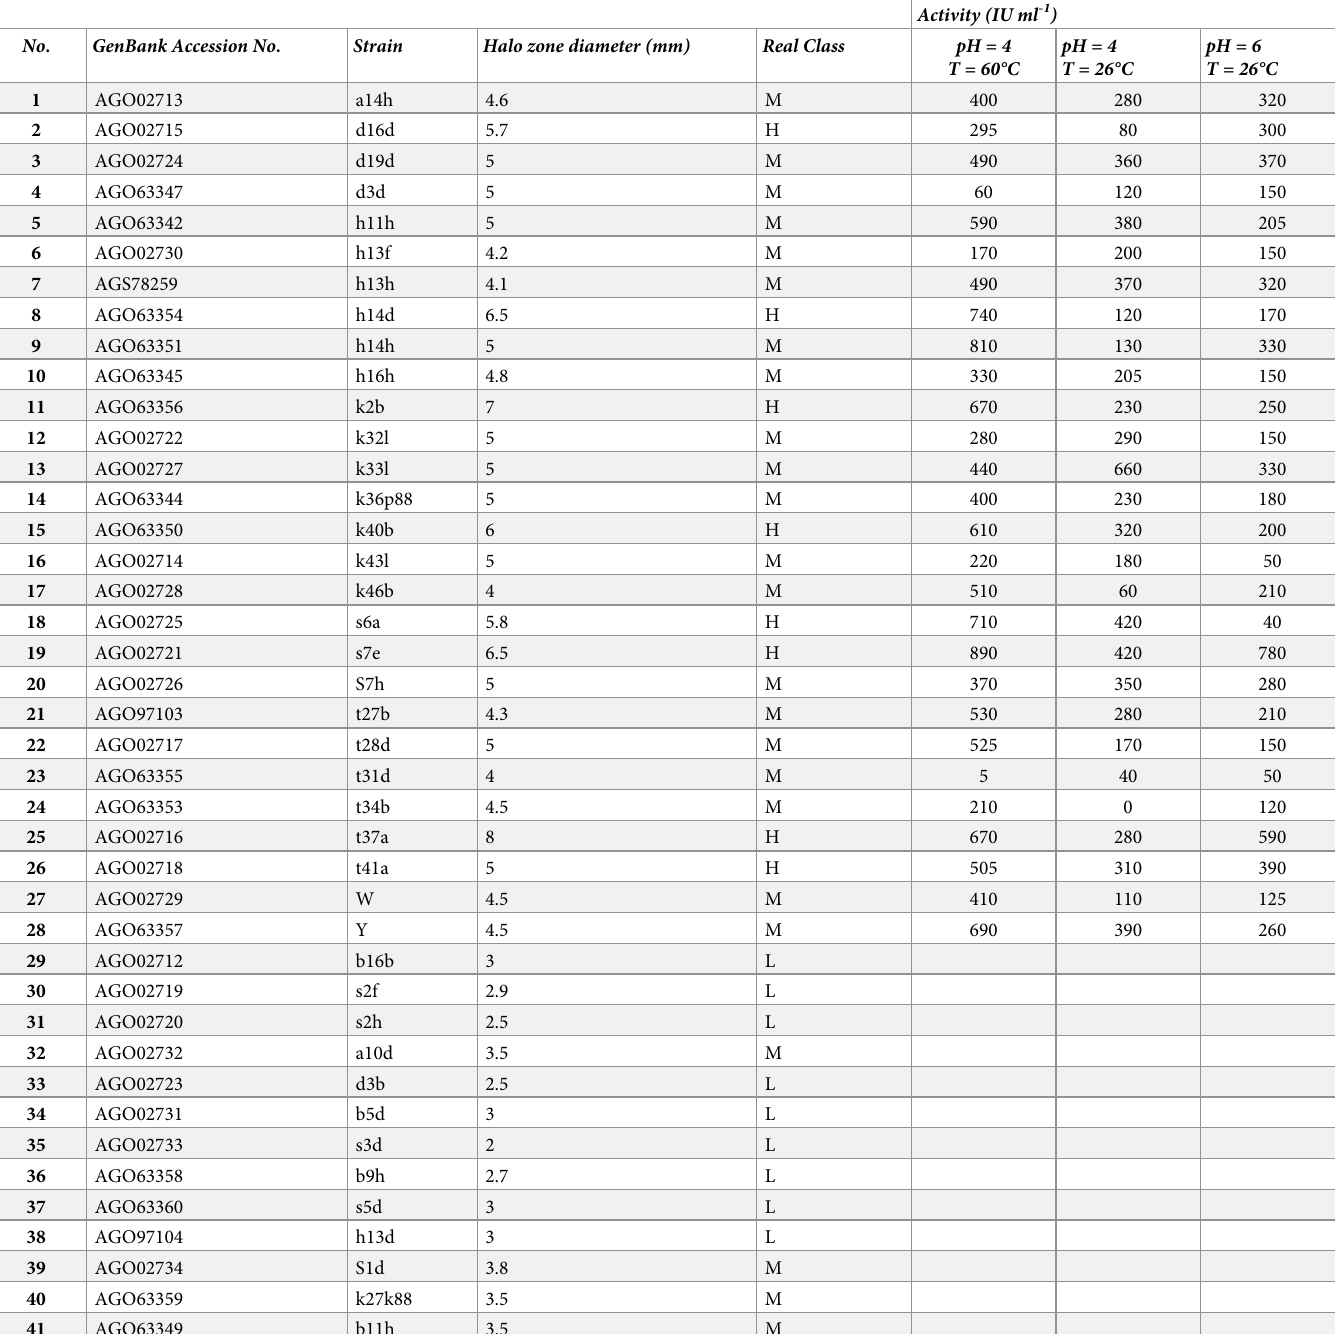
Table 1. 41 different xylanase enzymes were selected for experimental and computational studies. The GenBank Accession No., and its relevant strain code, for each sequence are included. The diameter of halos produced in the screening plates is also included for enzymes with high and medium halos surface. The last three columns shows the activities measured for 28 selected xylanase enzymes in three different pH and temperature